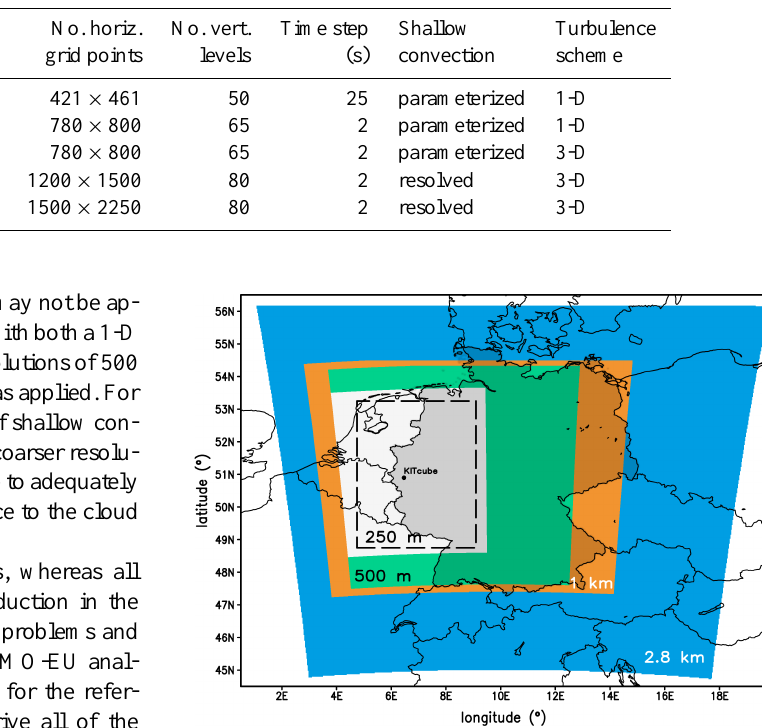
Table 1. Model configuration details.